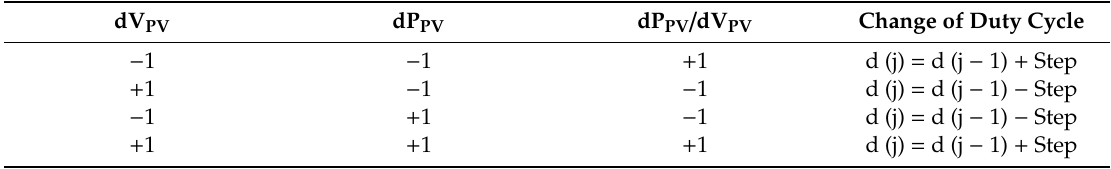
Table 1. Working behavior of the fixed step size radial basis functional algorithm (RBFA) based MPPT